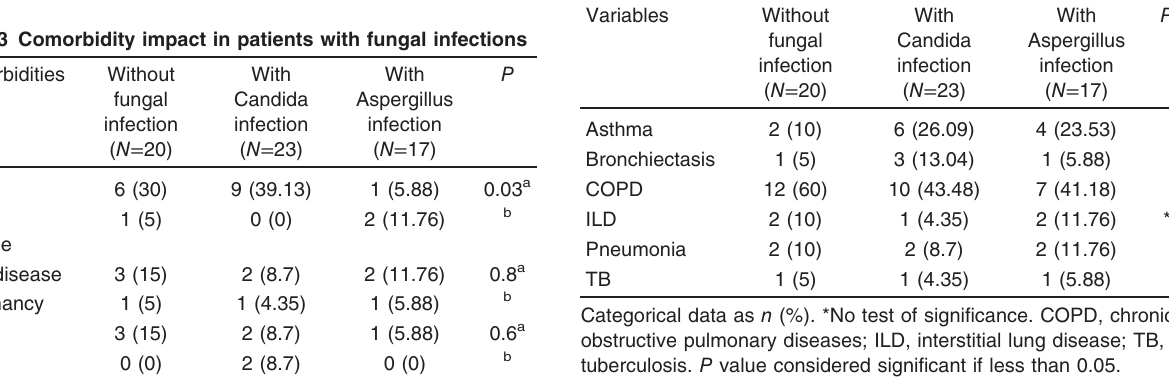
Table 6 Effect of the underling chest disease on fungal